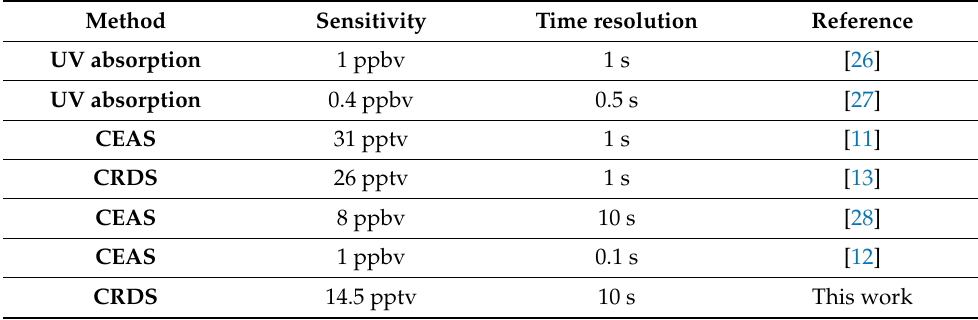
Table 1. Performance comparison of ozone